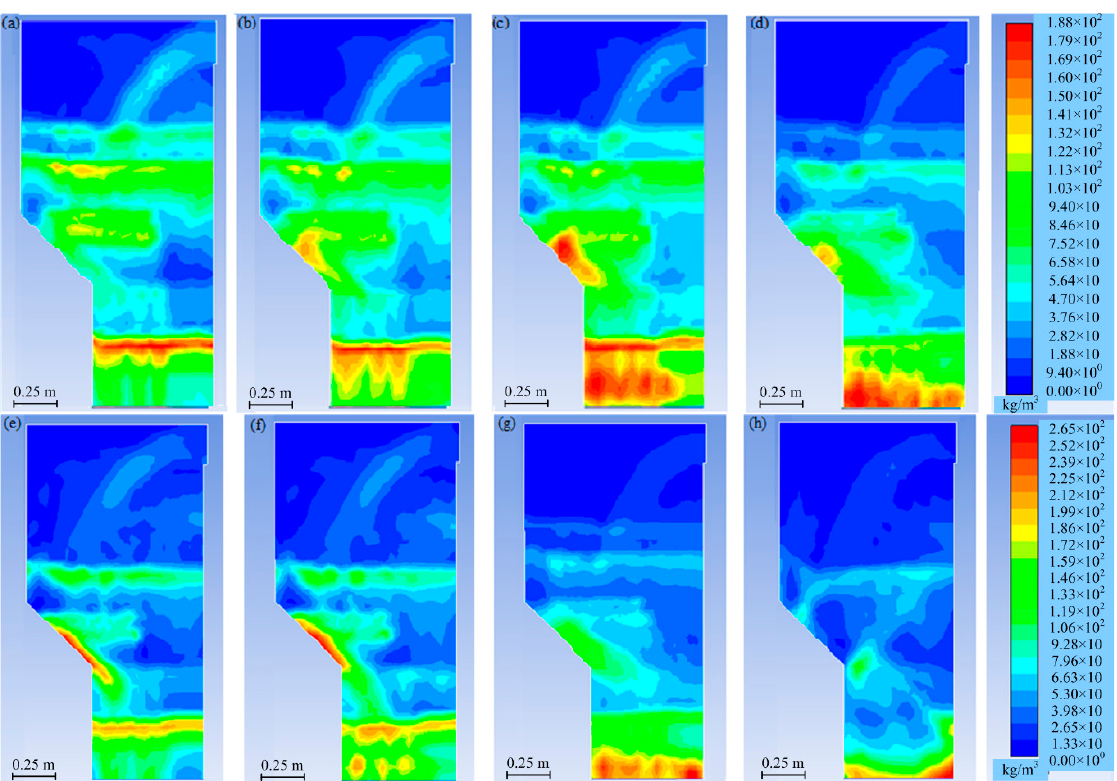
Figure 10. Cloud image of the dust concentration distribution in the chute system running from the start to the end: ( a ) MLG-S 0.5 s; ( b ) MLG-S, 0.6 s; ( c ) MLG-S, 0.7 s; ( d ) MLG-S, 0.8 s; ( e ) MLC-N, 0.5 s; ( f ) MLC-N, 0.6 s; ( g ) MLC-N, 0.7 s; ( h ) MLC-N, 0.8 s.